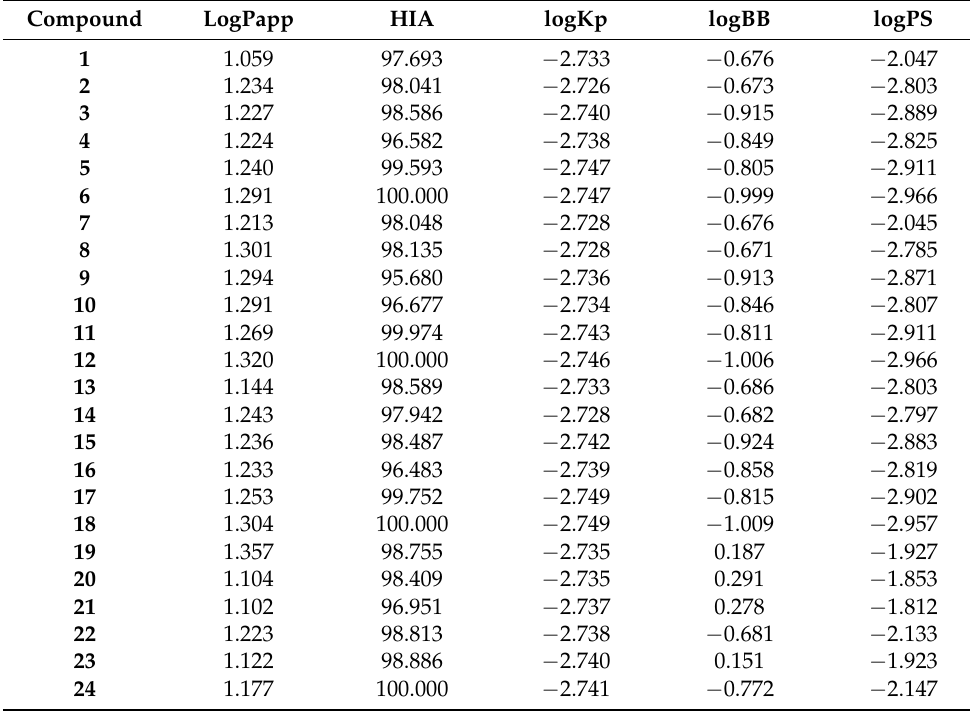
Table 8. Pharmacokinetic parameters of compounds 1 – 24